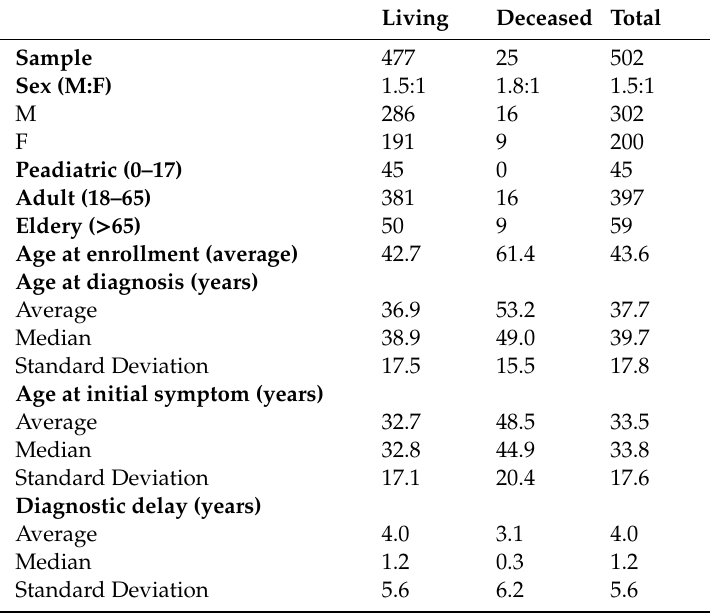
Table 1. Demographics and clinical characteristics of individuals with primary sclerosing cholangitis (1985–2014) registered in the Italian National Rare Diseases Registry.